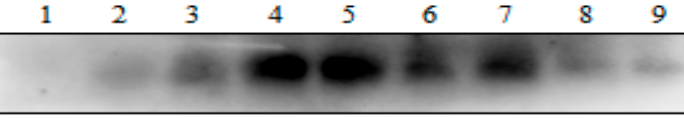
Figure 3. Analysis of gEGF expression by LL-pNZ8149-gEGF induced with nisin (10 ng/mL) using different induction times when the optical density of 600 nm (OD 600 ) of the bacterial cultures reached 0.4. Lanes 1–9: the 20 μ L/well of the supernatant from the induced cultures of the LL- pNZ8149-gEGF for 0, 3, 6, 9, 12, 15, 18, 21, and 24 h, respectively.